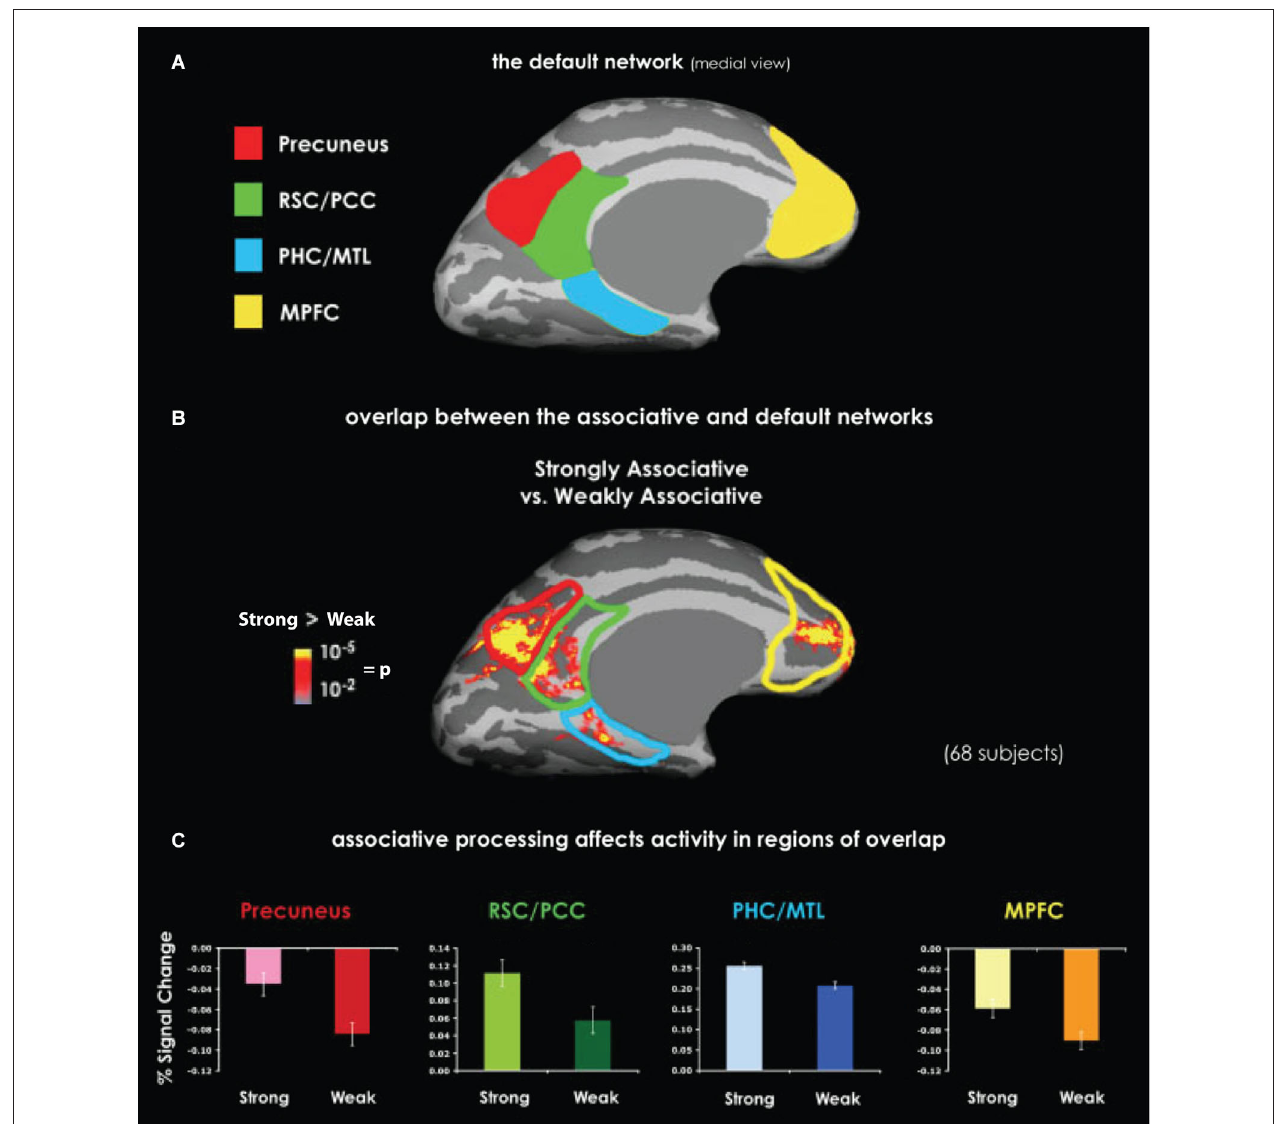
demonstrate the overlap between context processing and the default network. (C) Activity related to context processing in the regions of overlap with the default network, as manifested by percent of signal change. In each of these regions, highly contextual objects elicited either stronger positive or less negative activation compared with weakly contextual objects. Abbreviations: retrosplenial cortex (RSC), posterior cingulate cortex (PCC), parahippocampal cortex (PHC), medial temporal lobe (MTL), medial prefrontal cortex (MPFC). Adapted from Bar et al.